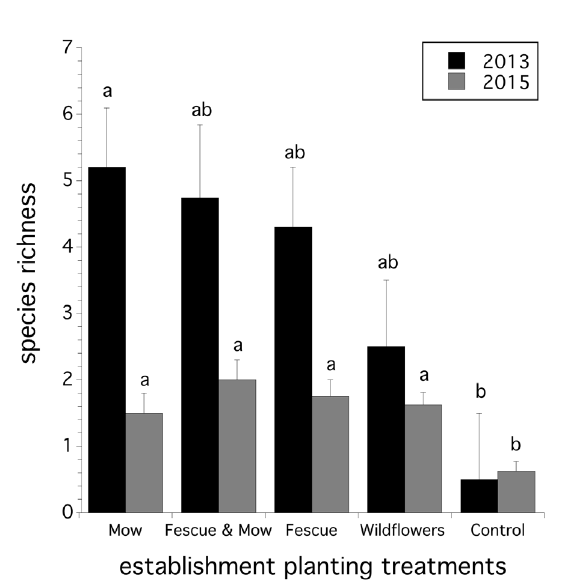
Figure 4 : The richness of sown wildflower species under establish- ment treatments, 2013 and 2015. Significant differences are denoted by letters. When letters are different, differences are significant